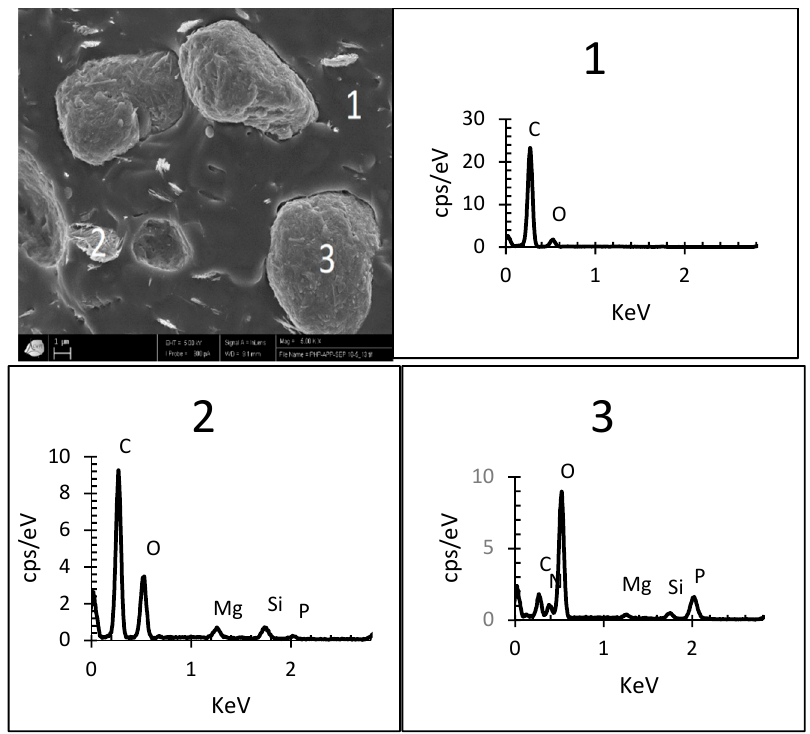
Figure 3. SEM images of PHB- APP-Sep. sample and analyzed zones by EDX. Table 3. EDX analysis of PHB-APP-Sep. sample on different areas. Elements (%wt.) Normalized at Area Number